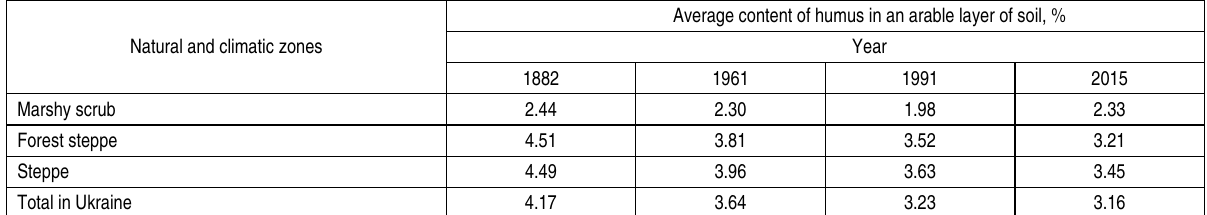
Table 3. Dynamics of humus content in soils of Ukraine for the last 133 years Natural and climatic